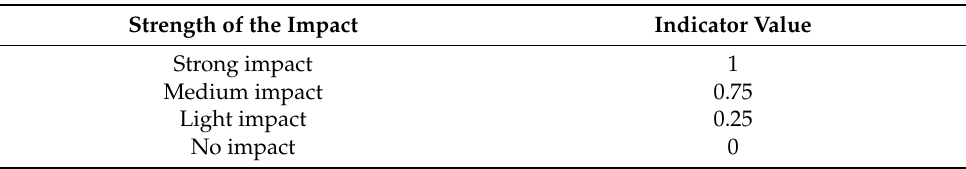
Table 3. Fragility impact